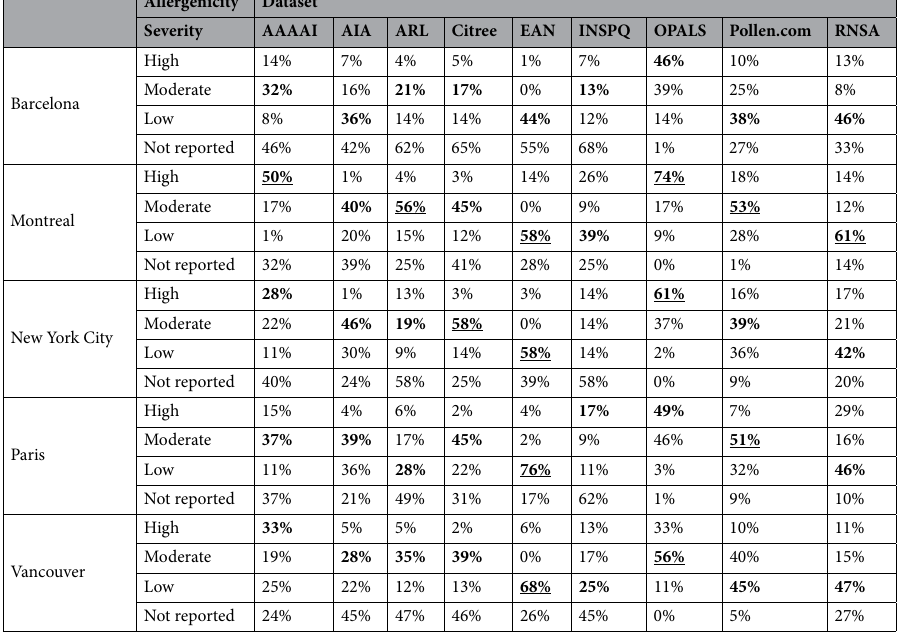
Table 2. Percentage of trees with high, moderate, or low allergenic pollen (allergenicity severity) to the total number of public trees for each city and dataset included in the study. The ‘not reported’ category includes the trees of certain species which pollen allergenicity has not been described in the respective dataset. For each city and dataset, the most frequent severity category is highlighted in bold and coefficients greater than 50% are underlined. Percentages per city may not add up to 100% due to rounding. All numeric values are shown in Supplementary Table